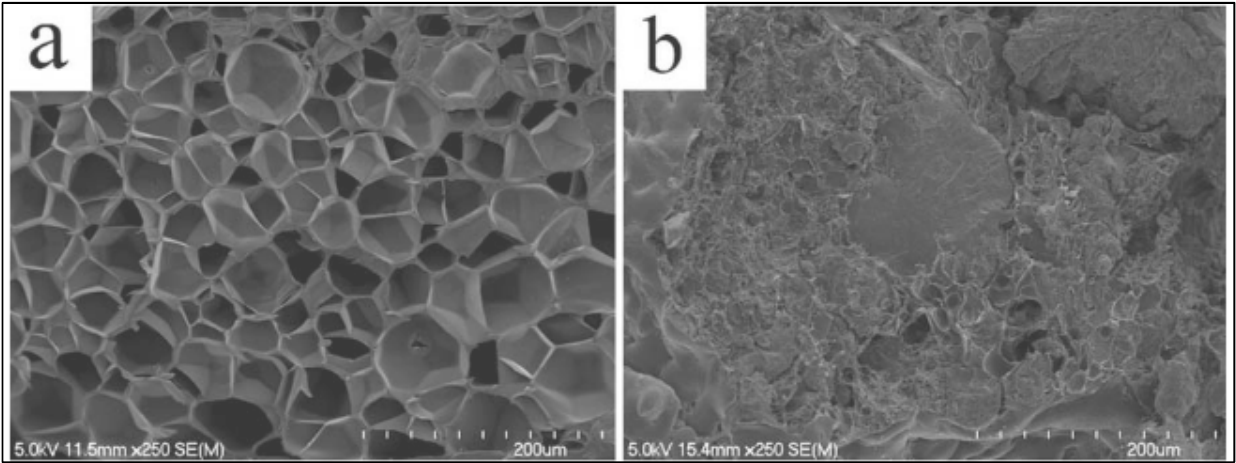
Figure 13. SEM micrographs of PLA/novatein 90/10 blends ( a ) uncompatibilized, ( b ) compatibilized (adapted from Walallavita et al. [61], copyright Wiley-VCH GmbH. Reproduced with permission). Compatibilizing effects of PLA- g -MA on the properties of PLA/Soy Protein concen- trate (SPC) blends were demonstrated by a 19% increase in tensile strength compared to the non-compatibilized blend [62]. Finally, PLA- g -MA also has the ability to provide some com- patibility to PLA/mineral mixtures such as PLA/carbon nanotubes [22], PLA/Titanium oxide [63], PLA/halloysite [64], PLA/hydroxyapatite [65], PLA/talc [66], PLA polyhedral oligomeric silsesquioxane (POSS)